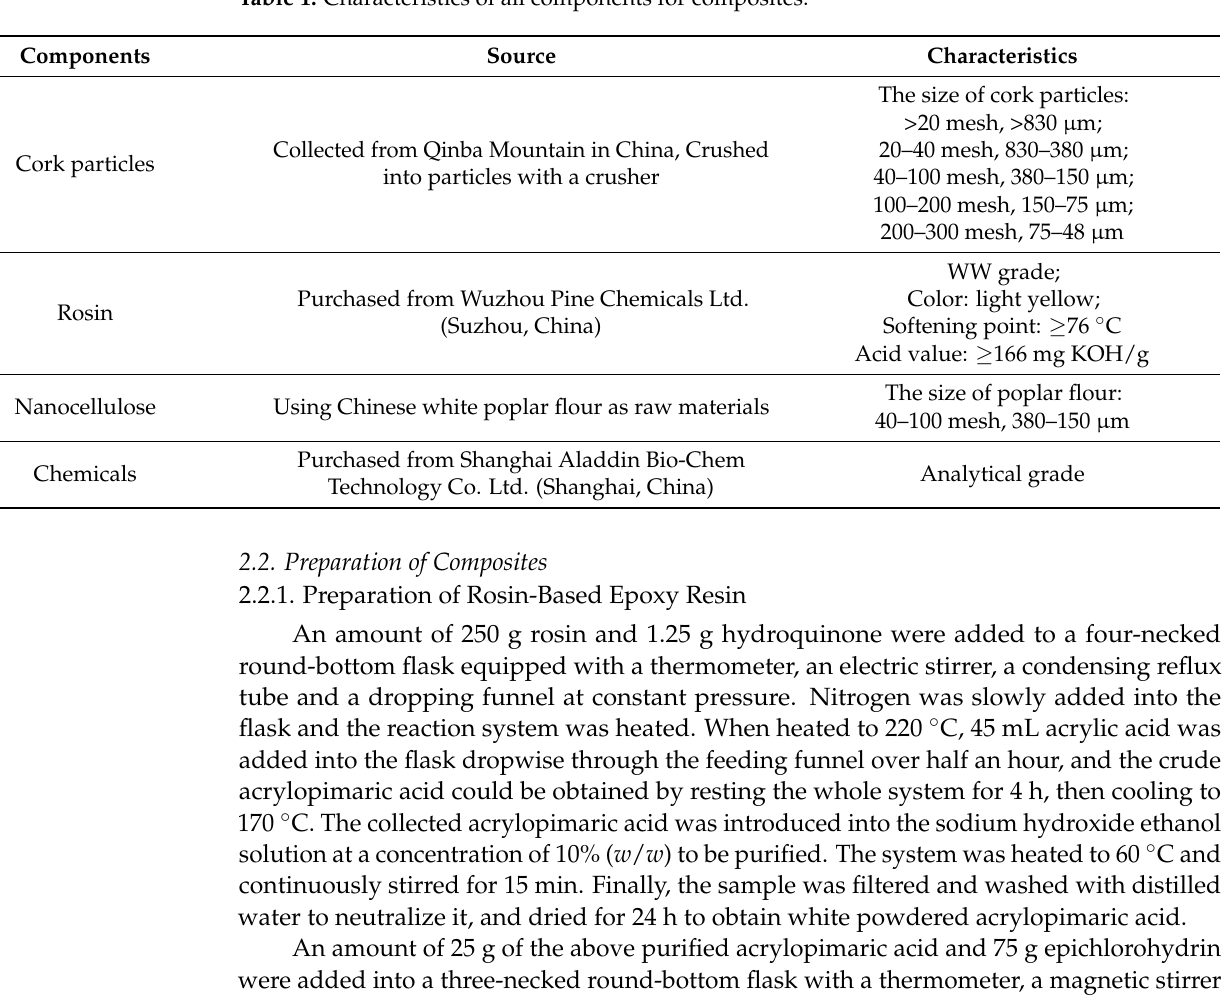
Table 1. Characteristics of all components for